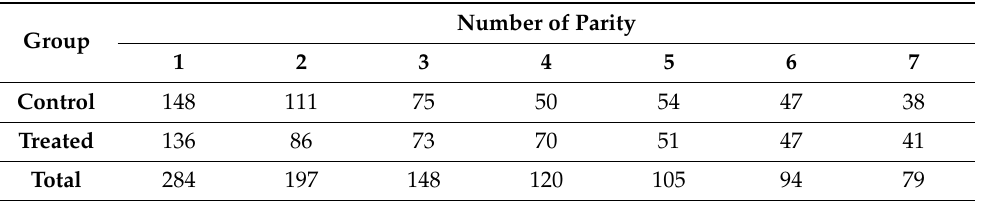
Table 1. Summary of the distribution, by treatment and number of parity, of the pregnancies assessed in the present study. Group